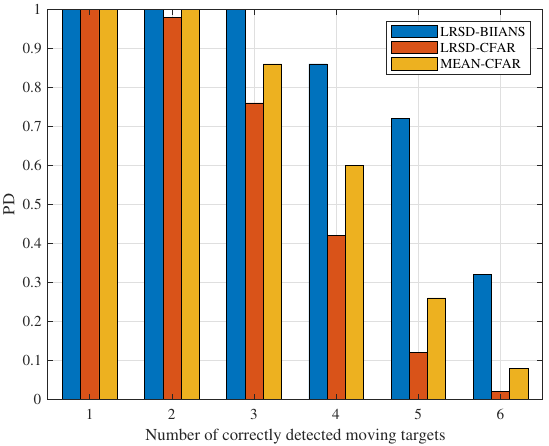
Figure 10. Comparison of the detection capability of different